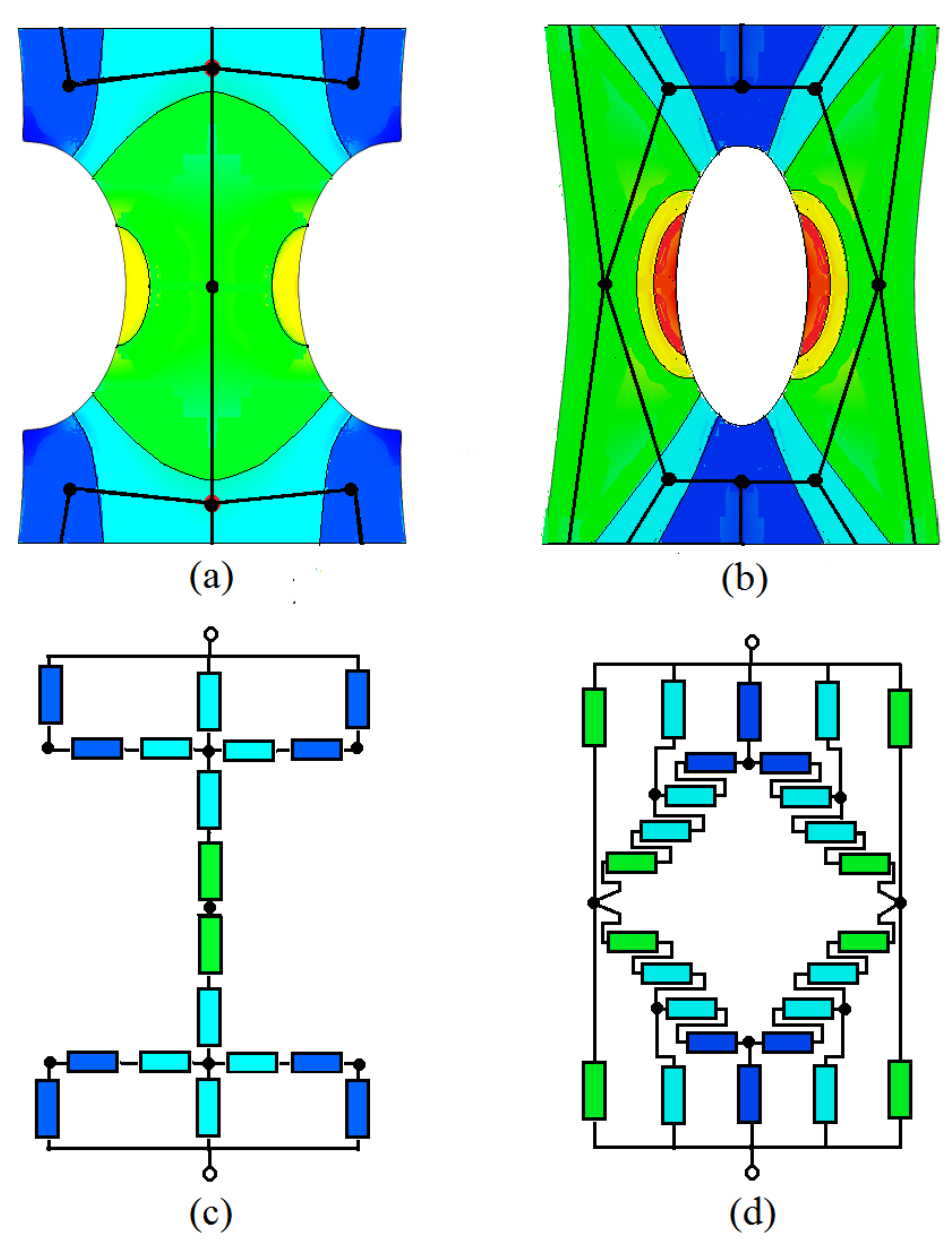
Figure 9. ( a ) Sketch defining the resistive domains with corresponding nodes for samples type b and ( b ) for samples type c, ( c ) The equivalent circuit for samples type b and ( d ) equivalent circuit for samples type c.